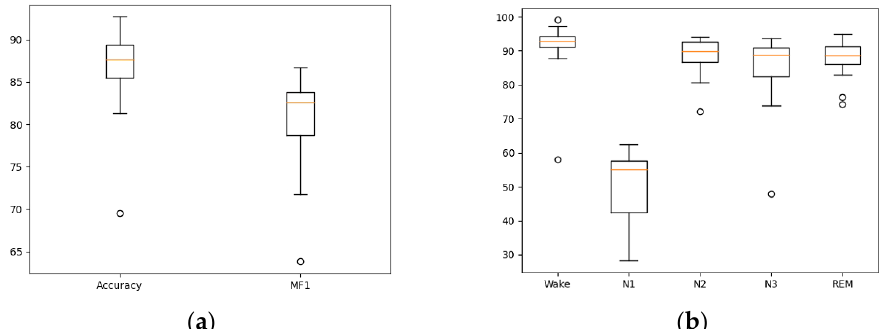
Figure 12. Distribution of the overall accuracy, MF1 and F1-score of each sleep stage of 20 subjects: ( a ) Accuracy and MF1, ( b ) F1 of each sleep stage.